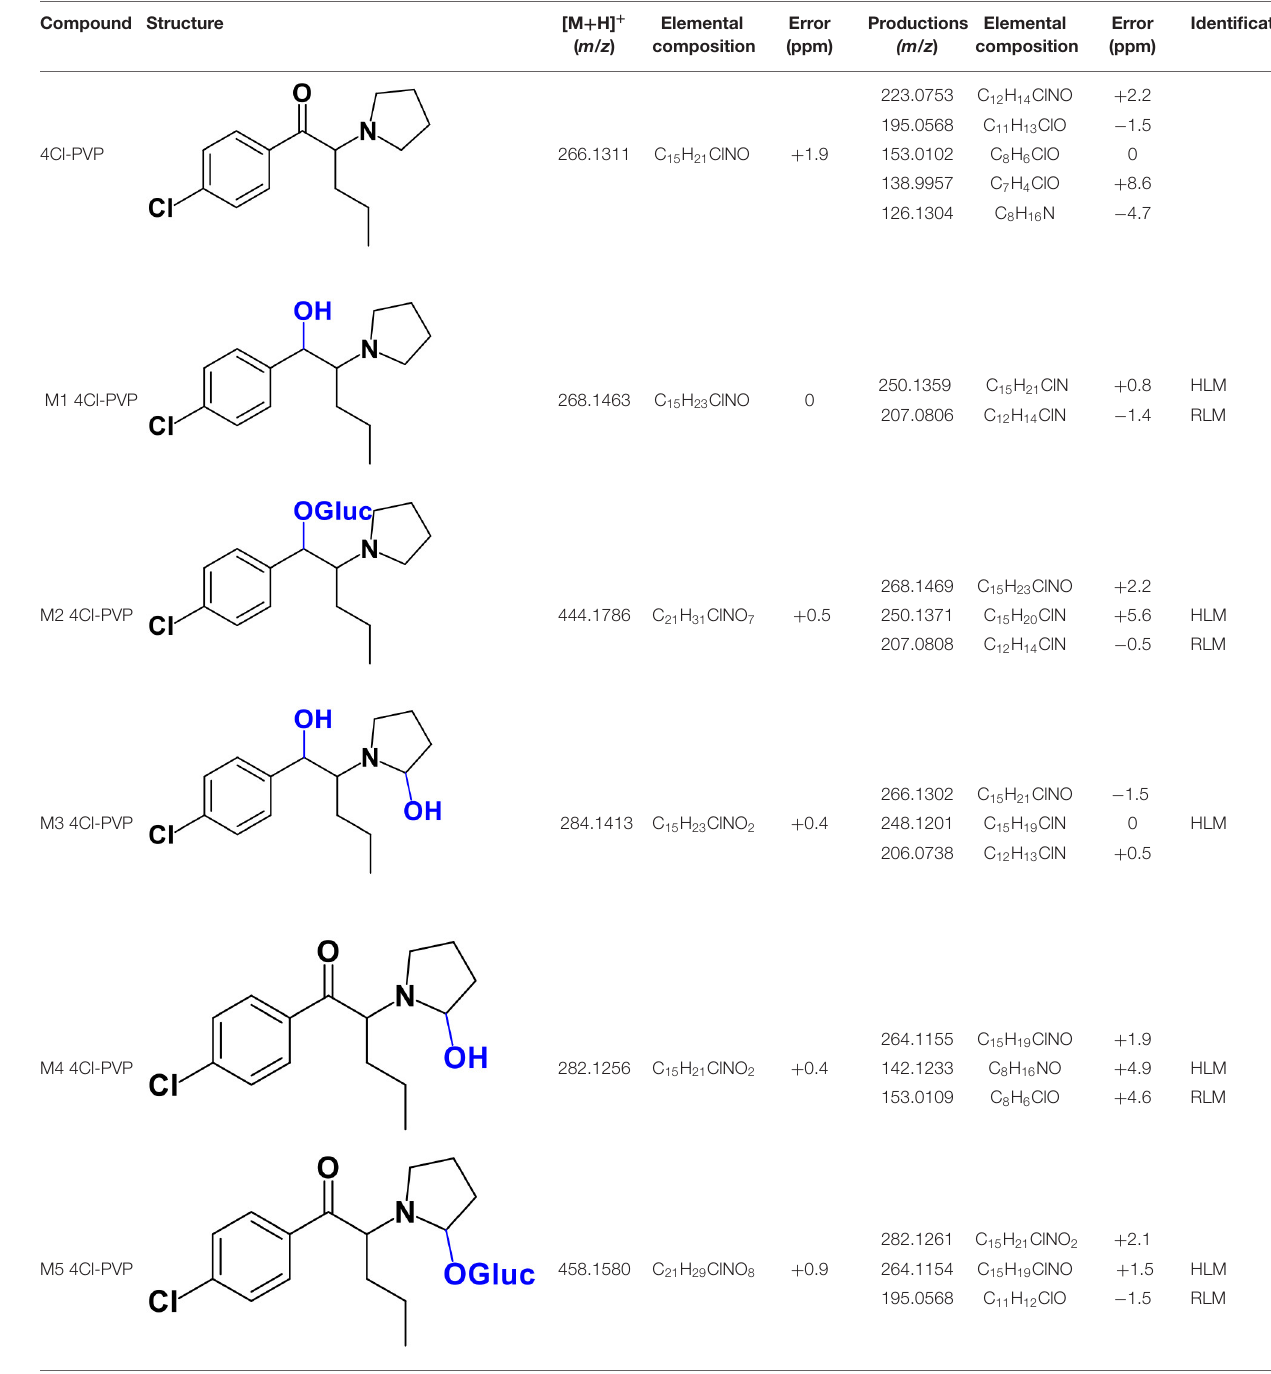
TABLE 2 | Structures of the 4Cl-PVP metabolites identified in HLM and RLM incubations by LC-HRMS/MS (ESI + ) analysis. Compound